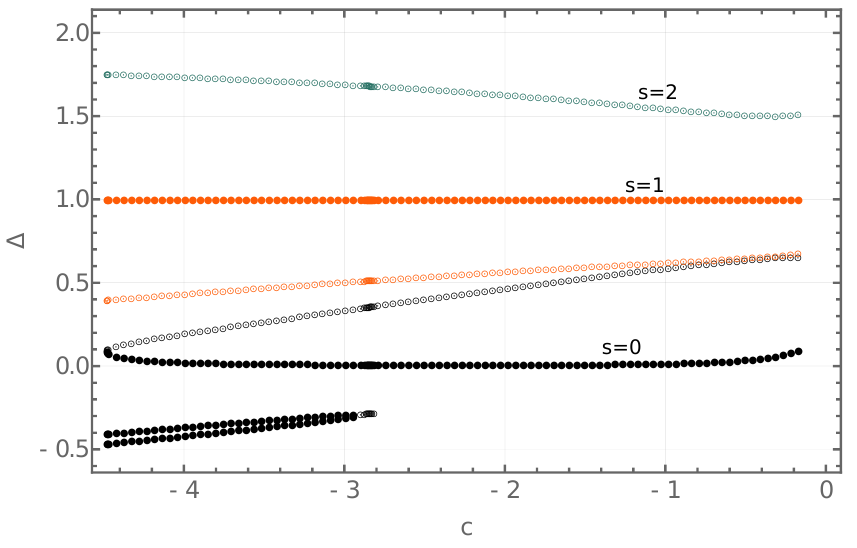
Figure 5 . Roots of the extremal functional evaluated at decreasing values of the central charge after addition of a double root at spin 0. Single roots are denoted by filled circles and double roots are denoted by dotted